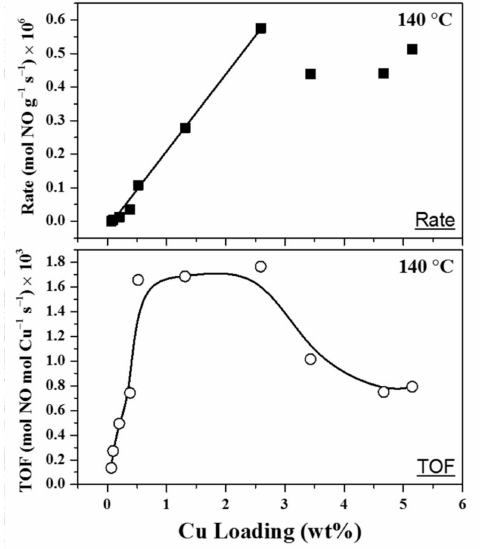
Figure 11. SCR rates (upper panel) and SCR turnover frequencies (lower panel) as a function of Cu loading at a reaction temperature of 140 ◦ C (a temperature used to readily obtain intrinsic, low-conversion reaction kinetics). The reactant feed contains 350 ppm NO, 350 ppm NH 3 , 14% O 2 , 2.5% H 2 O balanced with N 2 at a GHSV of 400,000 h − 1 . Reprinted from J. Catal. , 2014 , 319 , 1–14. Copyright 2014, with permission from